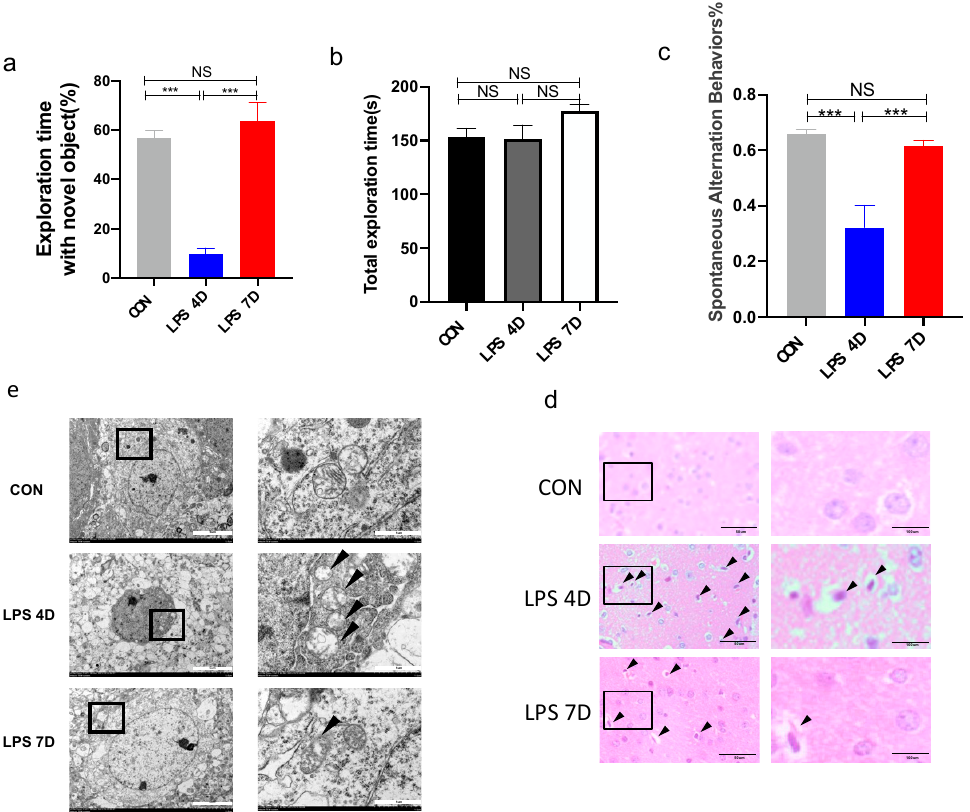
Figure 4. Improved cognitive dysfunction of mice injected for 7 consecutive days. ( a ) Percentage of detection time of new objects in each group of mice. ( b ) Total detection time of new and old objects for each group of mice. ( c ) Percentage of mice in each group entering the different arms of Y-maze in sequence. ( d ) HE staining of brain tissue sections of each group of mice. ( e ) Changes in mitochondria in central nervous system of mice in each group. NS indicates no statistical difference from the control group. * p < 0.05, ** p < 0.03, *** p < 0.01 compared with control, n = 6 mice per group.